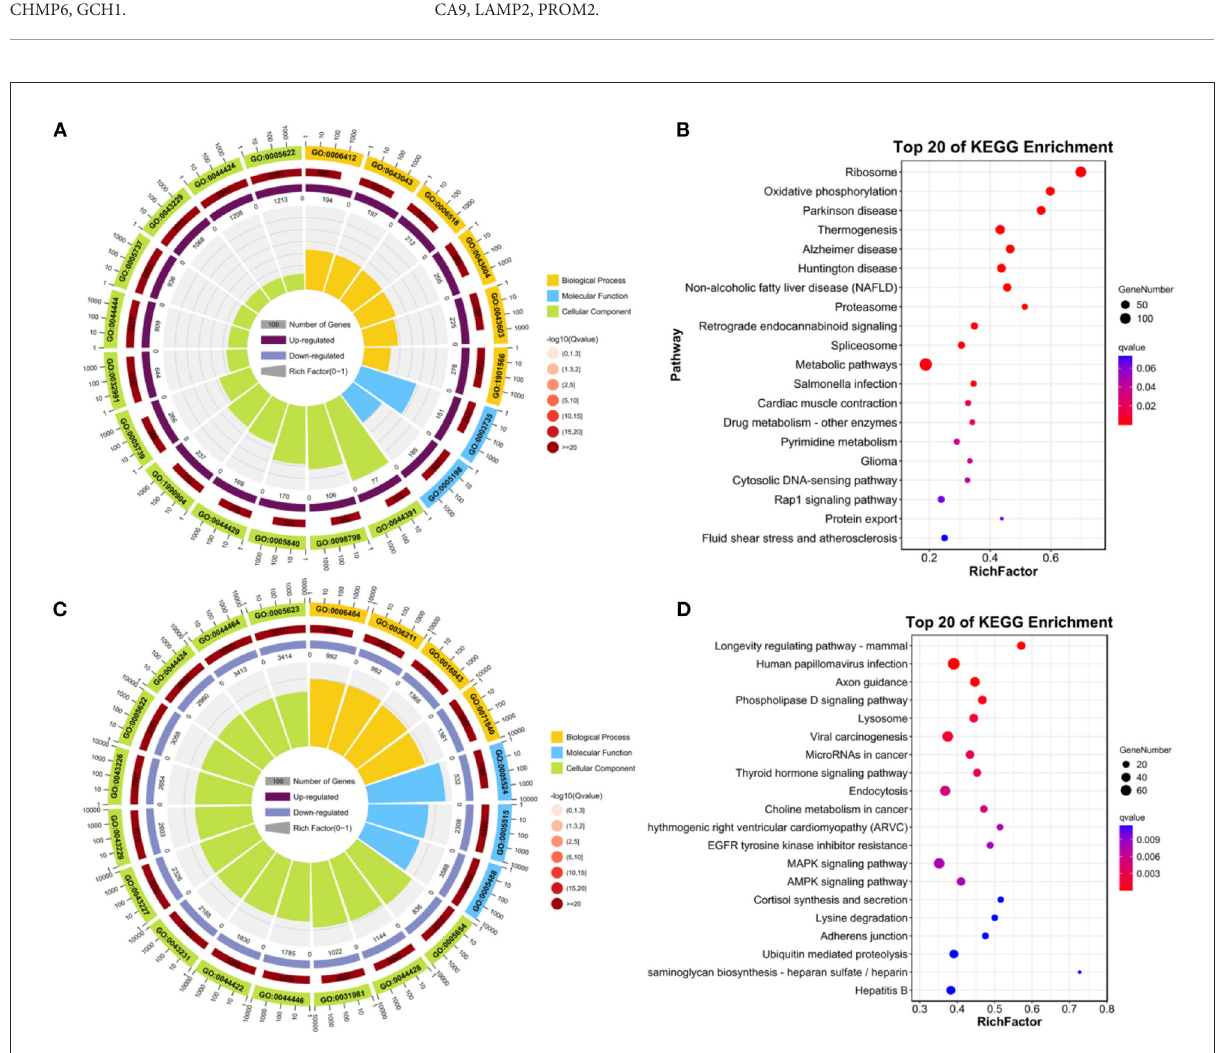
FIGURE4 Enrichment analysis of DEGs. (A) GO enrichment analysis of up-regulated DEGs. (B) KEGG analysis of up-regulated DEGs. (C) GO enrichment analysis of down-regulated DEGs. (D) KEGG analysis of down-regulated DEGs.